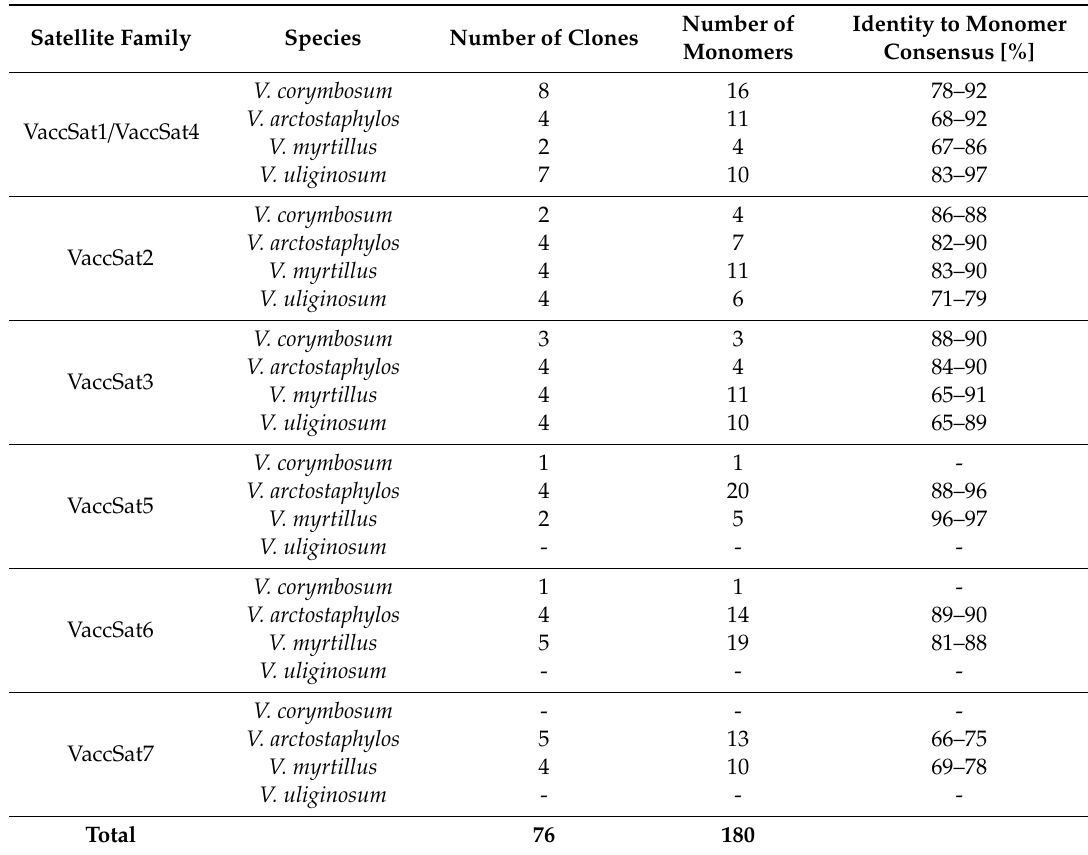
Table 4. Number of satellite clones, monomer sequences and similarity percentage of extracted full-length monomer sequences with consensus monomer sequences in di ff erent species of Vaccinium , Empty (-) = No consistent multimeric PCR amplification and hence no plasmid